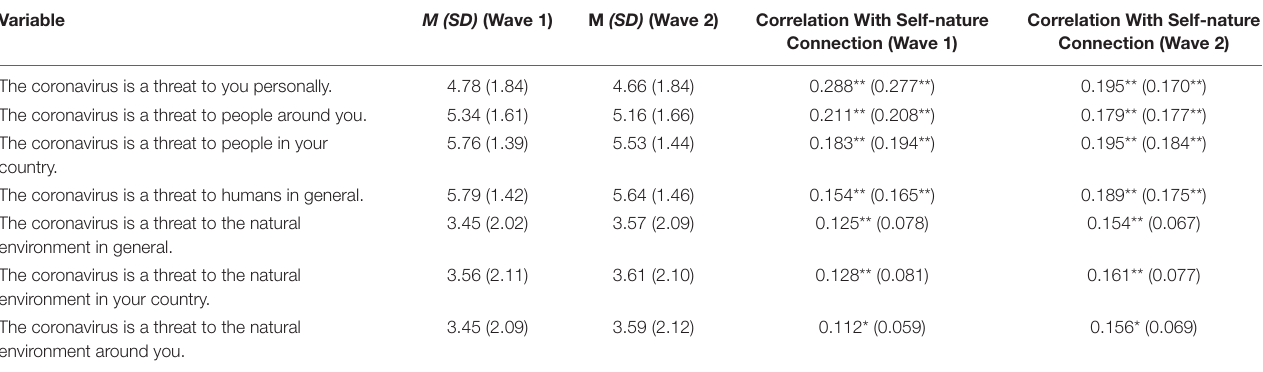
Connection (Wave